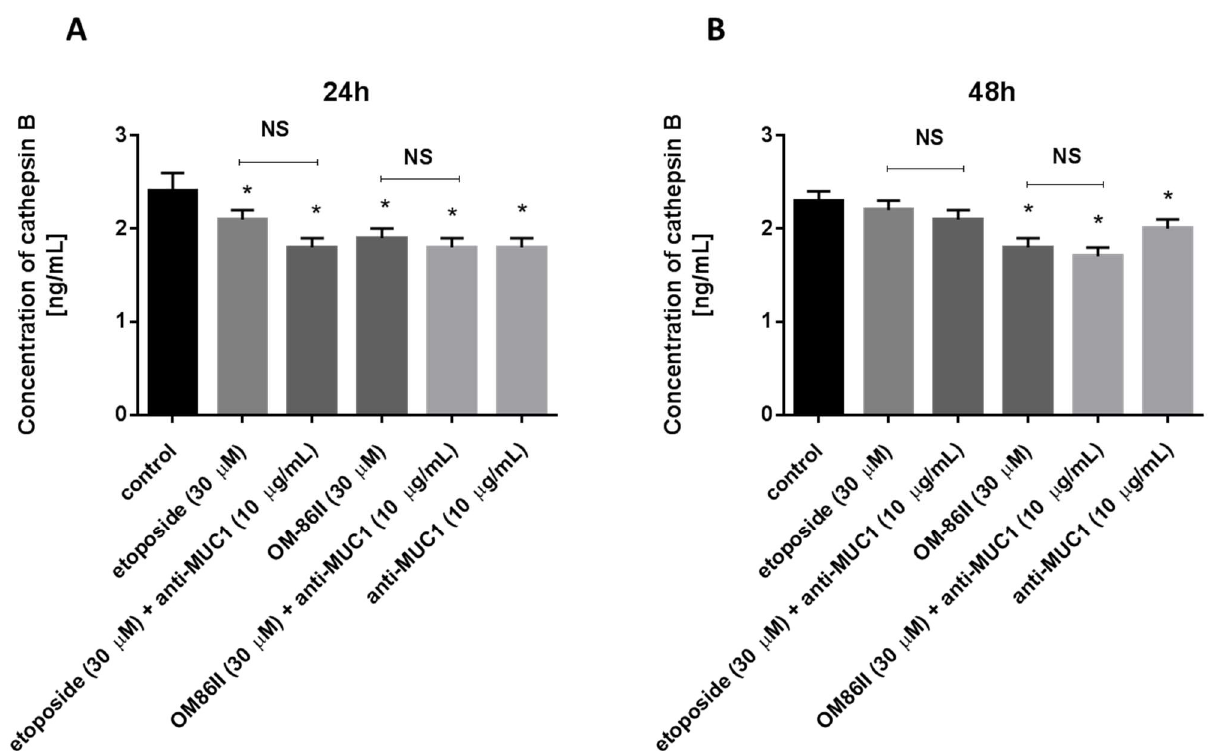
Figure 15. The concentration of cathepsin B in human gastric cancer AGS cells after 24 h ( A ) and 48 h ( B ) of incubation with anti-MUC1 (10 µ g/mL), OM-86II (30 µ M), OM-86II + anti-MUC1 (30 µ M + 10 µ g/mL), etoposide (30 µ M) and etoposide + anti-MUC1 (30 µ M + 10 µ g/mL). Data are presented in ng/mL. * p < 0.05 vs. control group; MUC1, mucin-1; OM-86II, octahydropyrazin[2,1-a:5,4-a′]diisoquinoline derivative; ns, not significant.